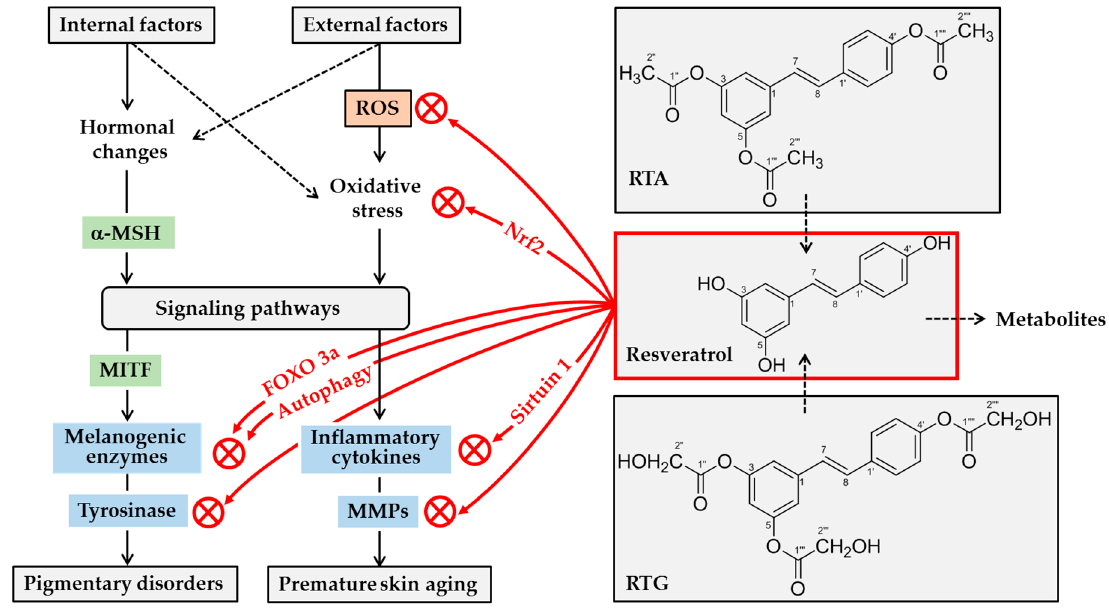
Figure 3. Potential mechanisms for skin lightening and antiaging actions of resveratrol. A variety internal and external factors can induce hormonal changes and oxidative stress, stimulating multiple signaling pathways linked to gene expression of melanogenic enzymes and inflammatory mediators. α -Melanocyte stimulating hormone ( α -MSH) stimulates gene expression of melanogenic enzymes by microphthalmia-associated transcription factor (MITF)-dependent mechanism. Resveratrol can attenuate oxidative stress of cells either by decreasing levels of reactive oxygen species (ROS), or by increasing antioxidant capacity via nuclear factor erythroid 2-related factor 2 (Nrf2). It can suppress the expression of inflammatory cytokines and matrix metalloproteinases (MMPs) by directly or indirectly activating sirtuin 1, an NAD-dependent deacetylase. It can directly inhibit the catalytic activity of MMPs. It can inhibit tyrosinase gene expression by multiple mechanisms involving either the activation of forkhead box O 3a (FOXO3a) or autophagy. Further, it can inhibit tyrosinase protein maturation, and / or tyrosinase catalytic activity. Topical application of resveratrol or its analogs, such as resveratryl triacetate (RTA) and resveratryl triglycolate (RTG), can reduce pigmentation and / or skin aging processes. Metabolites of resveratrol may have negative or positive e ff ects on skin health before they are excreted from the